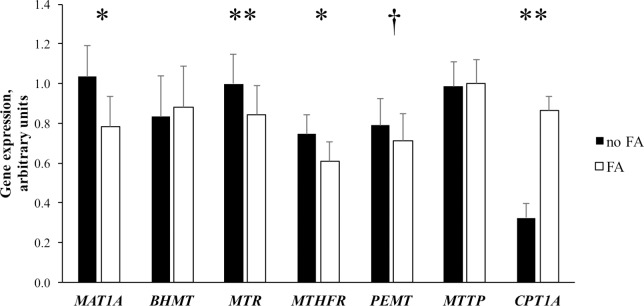
Expression of genes related to pathways of metabolism in transmethylation, lipid metabolism, and lipid oxidation in neonatal bovine hepatocytes exposed to increasing concentrations of choline chloride and DL-methionine in the presence (closed bars) or absence (open bars) of a 1 mmol/L fatty acid cocktail.The main effects of fatty acid (FA) treatment are shown; there were no interactions between the methyl donor or FA treatment. Values are least squares means, with SE represented by vertical bars. Effects are denoted as tendency (P ≤ 0.10, †) and significant (P ≤ 0.05, *; P ≤ 0.001, **). Methionine adenosyltransferase 1A (MAT1A), betaine-homocysteine S-methyltranferase (BHMT), 5-methyltetrahydrofolate-homocysteine methyltransferase (MTR), methylenetetrahydrofolate reductase (MTHFR), phosphatidylethanolamine N-methyltransferase (PEMT), microsomal triglyceride transfer protein (MTTP), carnitine palmitoyltransferase 1A (CPT1A).